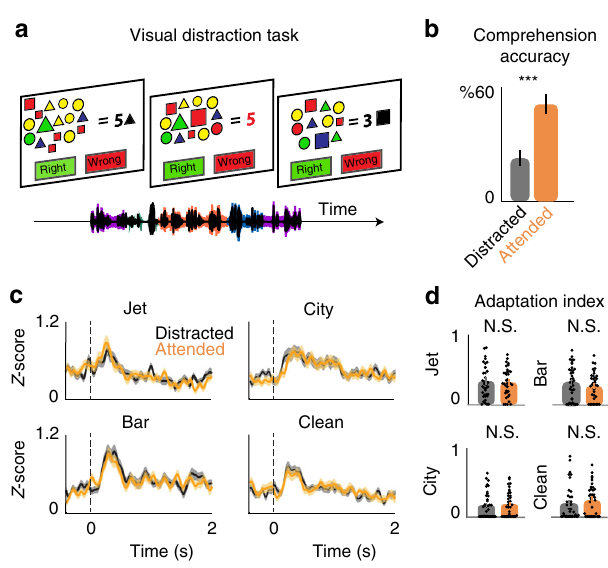
Fig. 6 The effect of attention on neural adaptation. a Schematic of the visual distraction task performed to divert the attention of subjects from the noisy speech task. b Subjects ’ behavioral response accuracy in response to the contextual questions from speech stories in two conditions of Distracted (Black) and Attended (orange) (mean ± s.e.m., N distracted = 48, N attended = 96, ***Yate ’ s corrected chi-square test, p < 0.01). c , d Comparison of adaptation patterns and adaptation indices in response to the noisy speech task for the two conditions of Distracted and Attended (mean ± s.e.m. across electrodes, N =